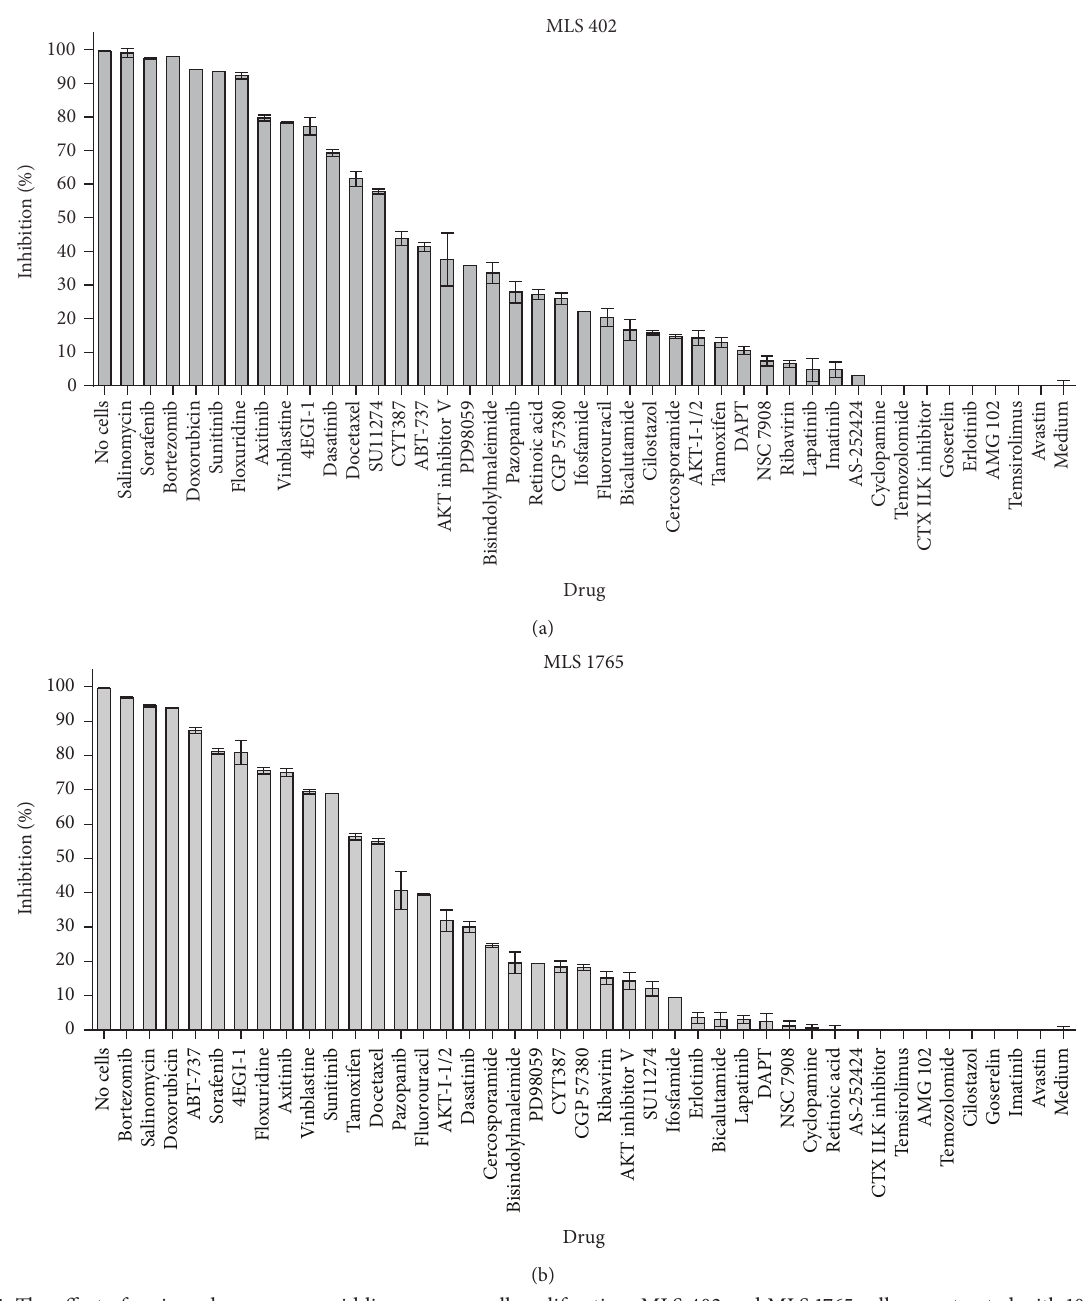
Figure 1: The effect of various drugs on myxoid liposarcoma cell proliferation. MLS 402 and MLS 1765 cells were treated with 10 𝜇 M drug (10mg/mL bevacizumab) for 5 days. Following MTS dye uptake assay, cell viability was determined. Various agents inhibited the proliferation of MLS 402 (a) and MLS 1765 (b). Tests were performed on three technical replicates. The data are presented as the mean ± SEM and are expressed as the percentage inhibition compared with vehicle-treated